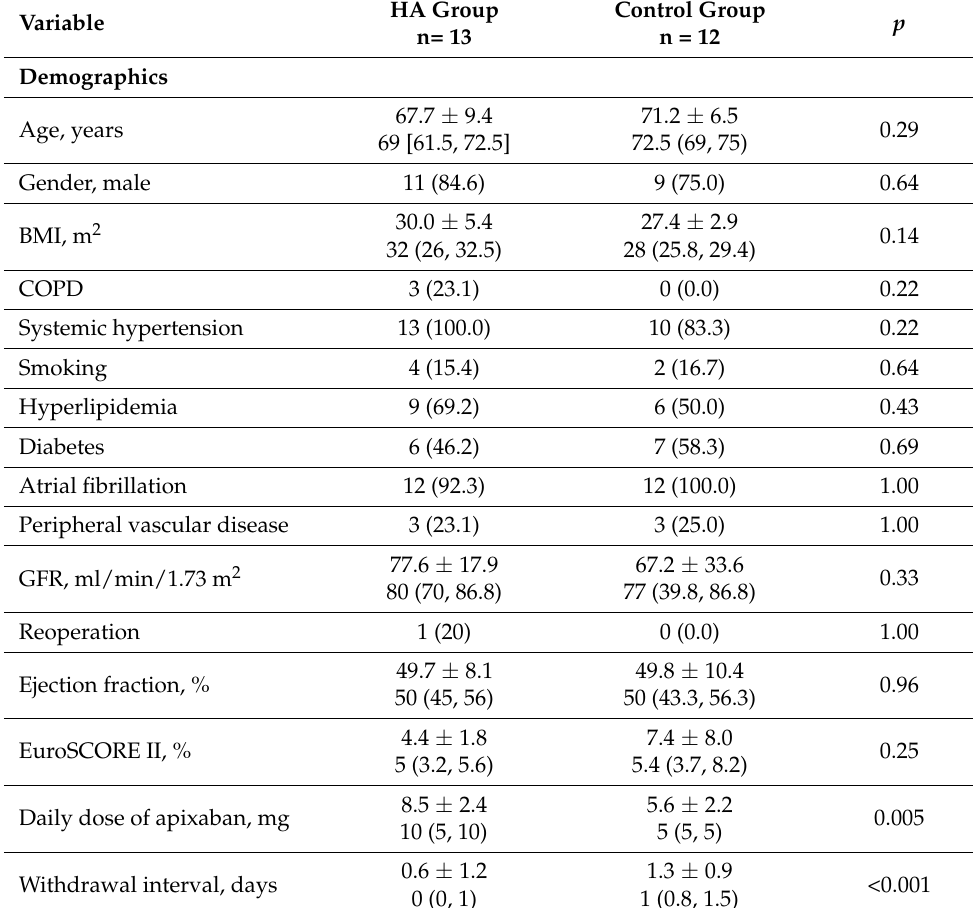
Table 1. Baseline